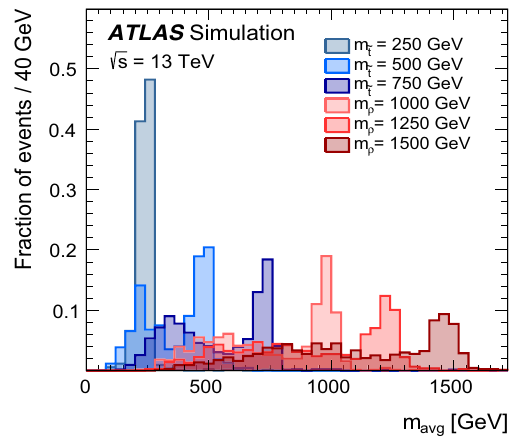
Fig. 3 Distribution of the average mass, m avg , in the inclusive signal region for simulated top squark signals with m ˜ t = 250, 500, and 750 and coloron signals with m ρ = 1000, 1250, and 1500 GeV